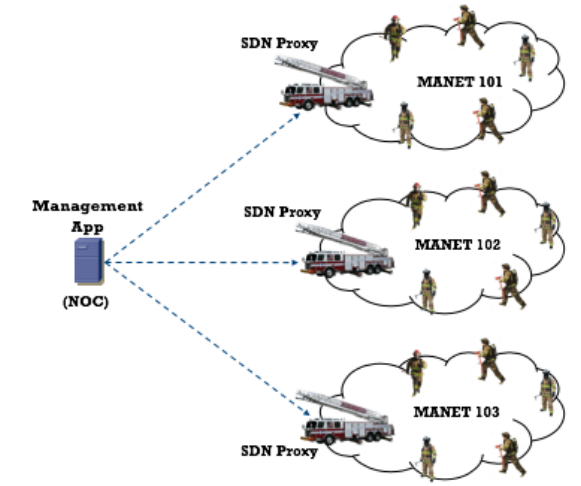
Figure 19. Extension of SDN Proxy